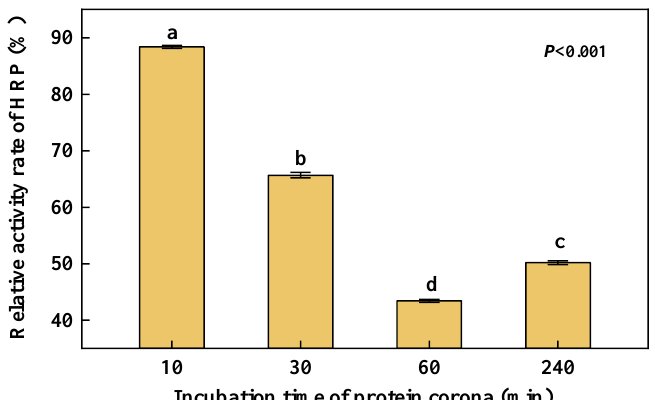
Figure 6. Relative activity changes of HRP with incubation time. Dates are means ± SE ( n = 3). Different letters indicate a significant difference at p < 0.05.